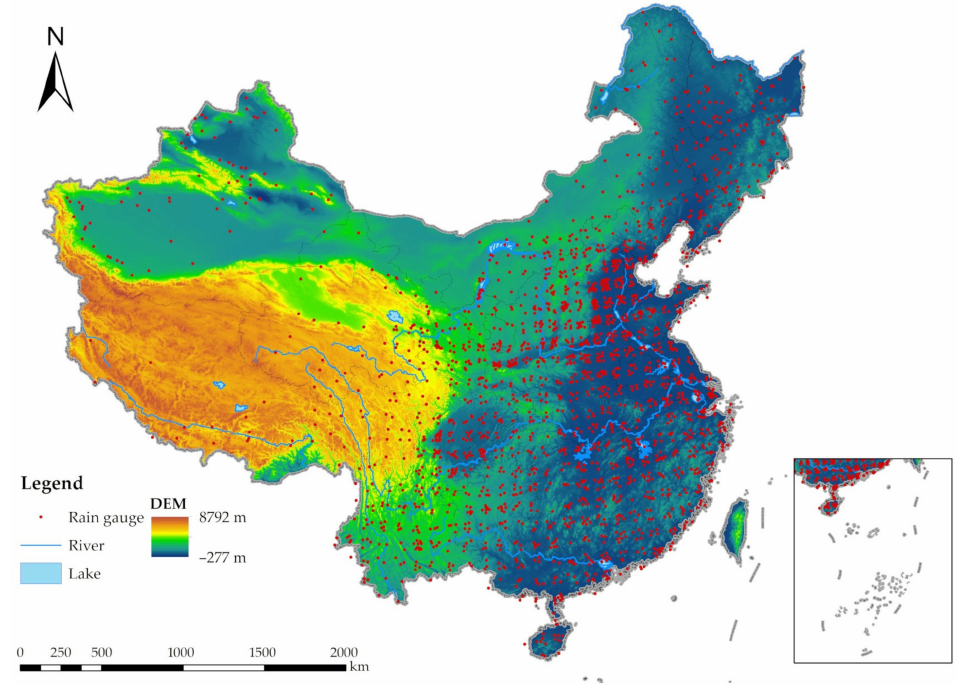
Figure 1. Study area and position of rain